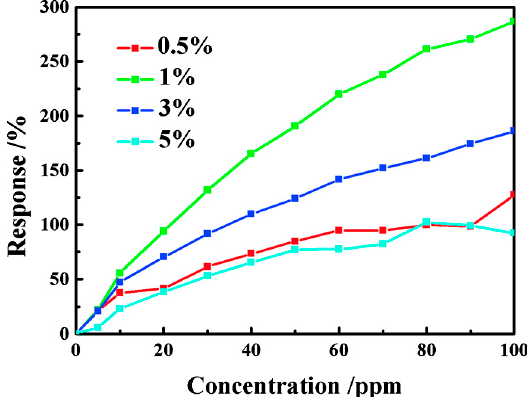
Figure 68. ( a ) Absorption spectrum and ( b ) Photocurrent of Fe-doped flowerlike ZnO with the ratio of Fe/ZnO from 0.1 mol % to 5 mol %. Reproduced with permission from [99]. Figure 69. HCHO sensing response of Fe-doped ZnO nanoflowers (with the ratio from 0.5 mol % to 5 mol %) under 532 nm light illumination. Reproduced with permission from [99].